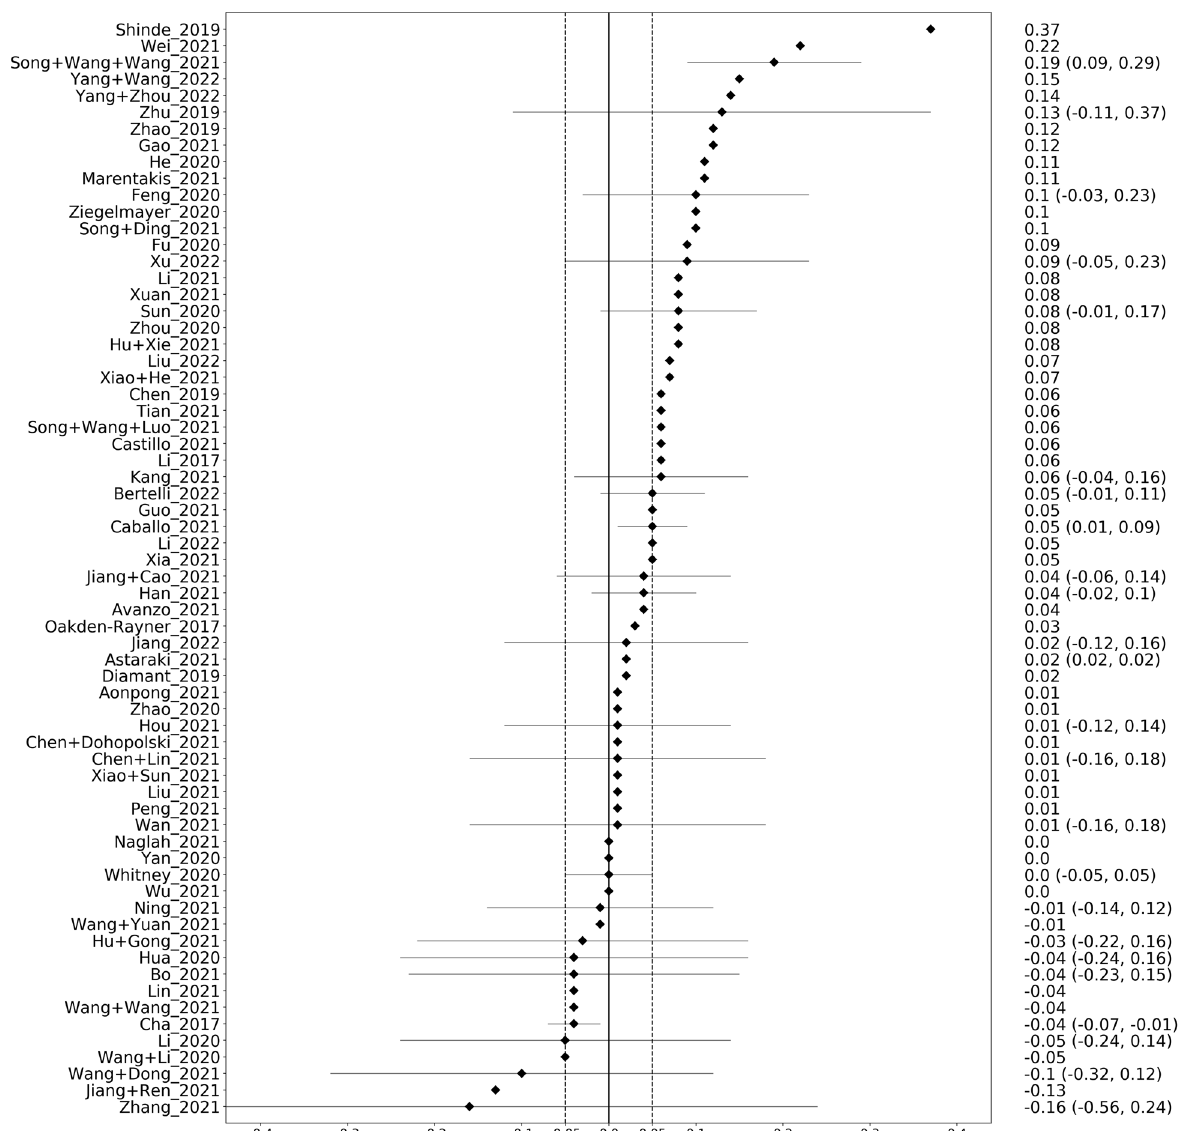
Fig. 4 Graphical display of the performance differences between the generic and deep models on the internal validation sets. On the right, the difference in area under the curve together with the 95% confidence interval is given. A positive difference means that the deep model performed better than the generic